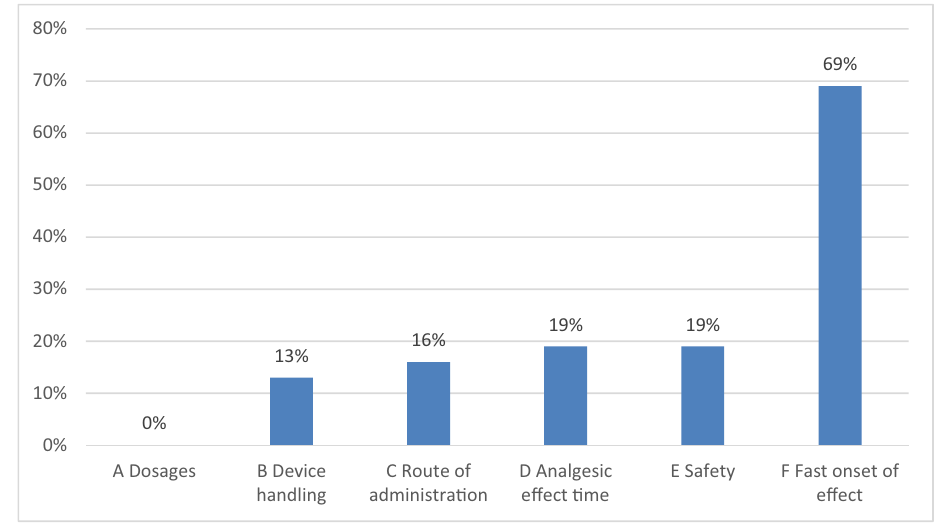
Figure 3: Survey question: “ Which characteristic of a rapid onset opioid is the most important feature of your choice?.